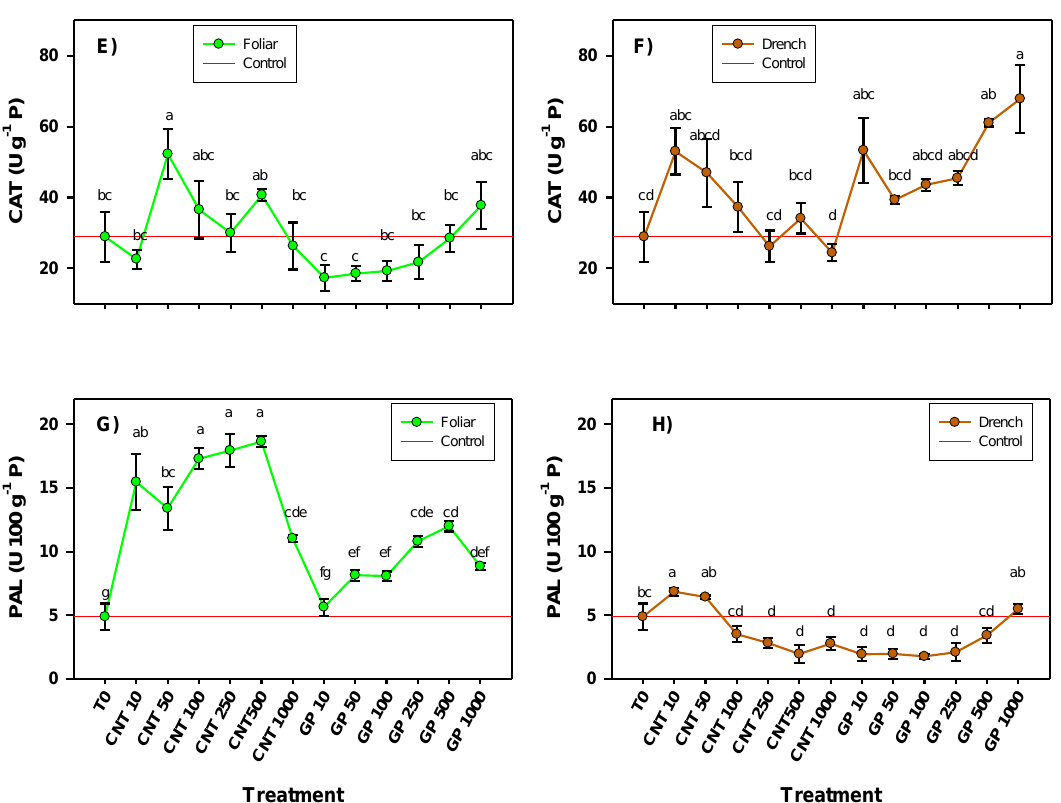
Figure 6. Enzymatic activity (ascorbate peroxidase ( A , B ), glutathione peroxidase ( C , D ), catalase ( E , F ), and phenylalanine ammonia lyase ( G , H ) in tomato seedlings treated with carbon nanomaterials applied via foliar and drench. T0: control; CNTs: carbon nanotubes; GP: graphene; P: proteins; 10, 50, 100, 250, and 500 represent the mg L − 1 applied of each carbon nanomaterial. Di ff erent letters indicate significant di ff erences among treatments according to Duncan ( α = 0.05). n = 5 ± standard error.